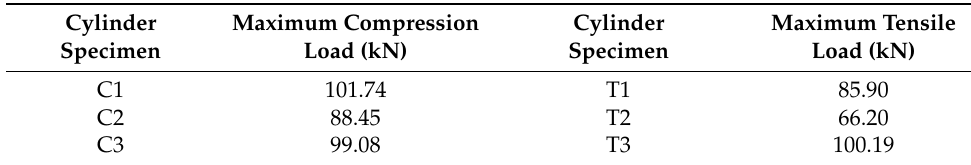
Table 3. Mechanical properties of the concrete mixture.